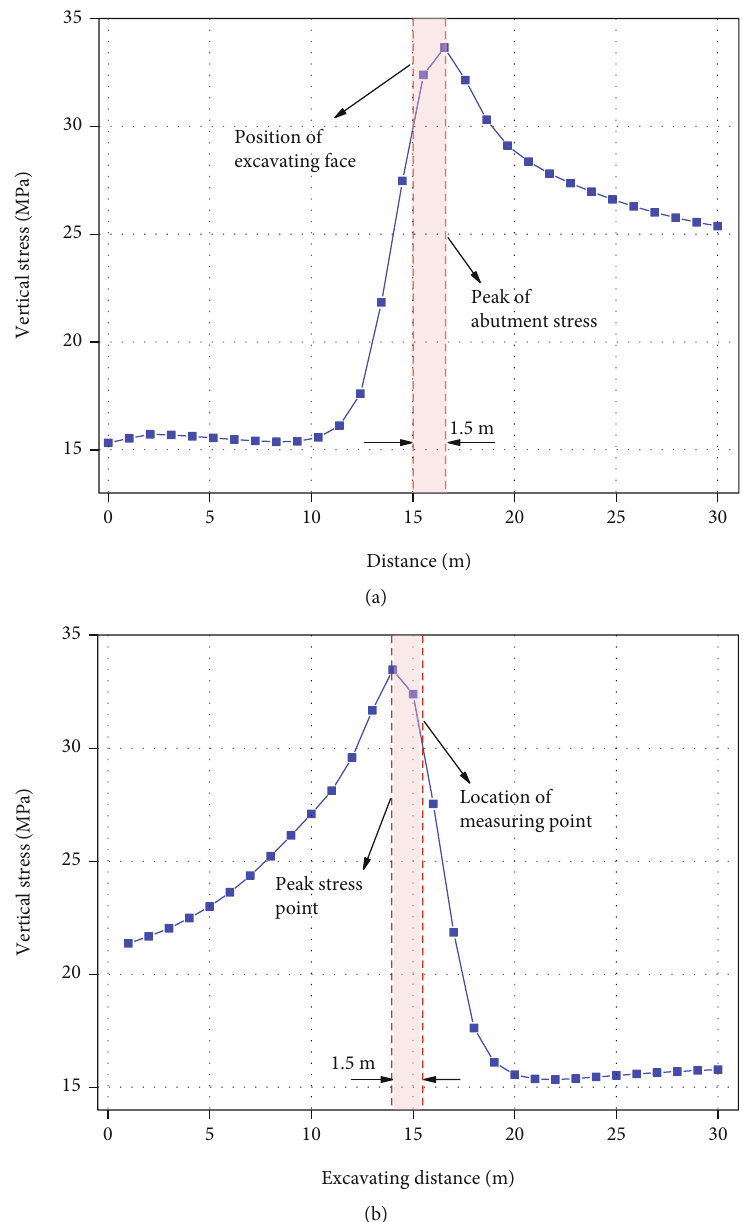
Figure 7: Characteristics of coal pillar rib stress disturbance during cyclic excavation of gob-side roadway: (a) the vertical stress distribution law of the coal pillar rib along the axial direction of the roadway when the roadway is excavated to 15m and (b) the vertical stress evolution law of coal pillar rib at 15.5m of roadway mileage during 30m of roadway